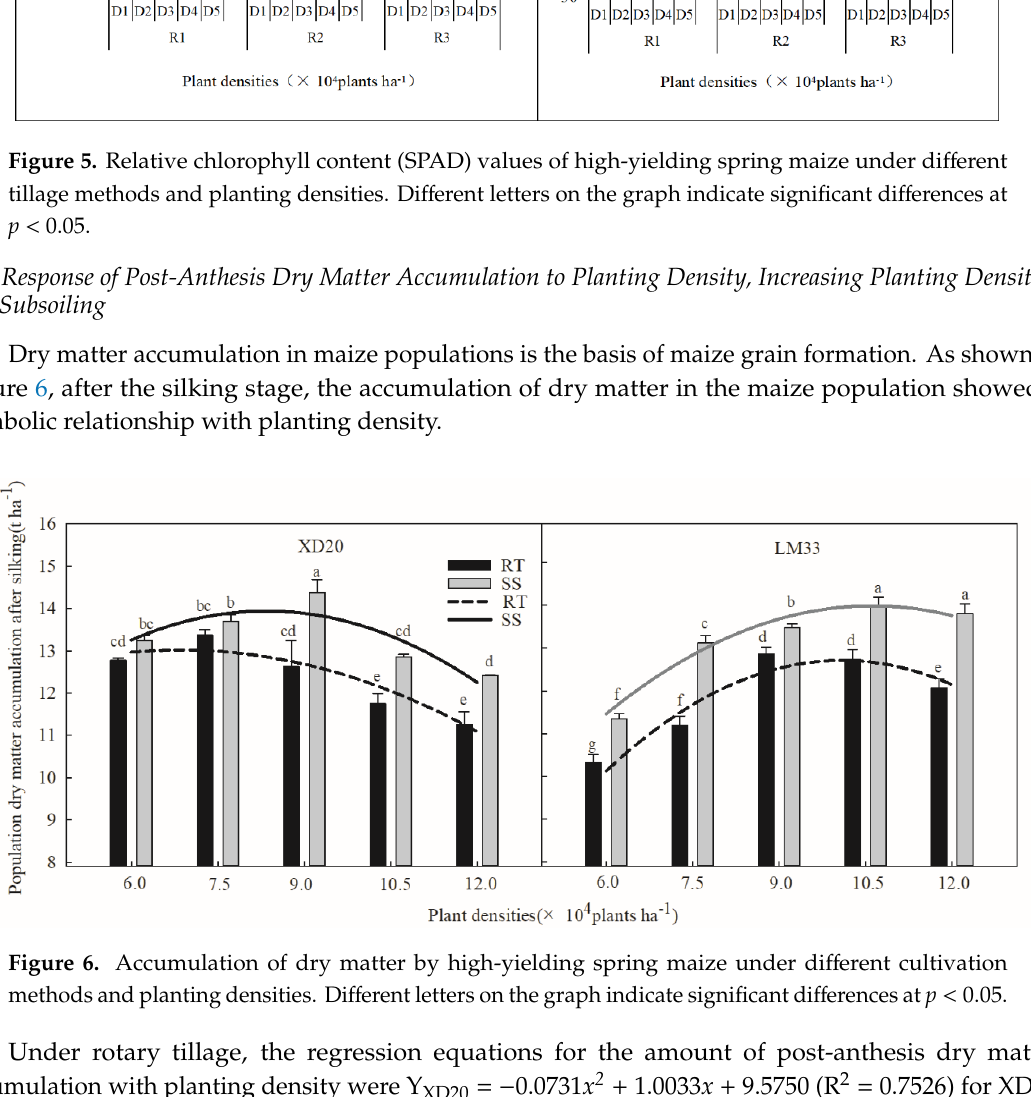
Figure 5. Relative chlorophyll content (SPAD) values of high-yielding spring maize under different tillage methods and planting densities. Different letters on the graph indicate significant differences at p < 0.05.